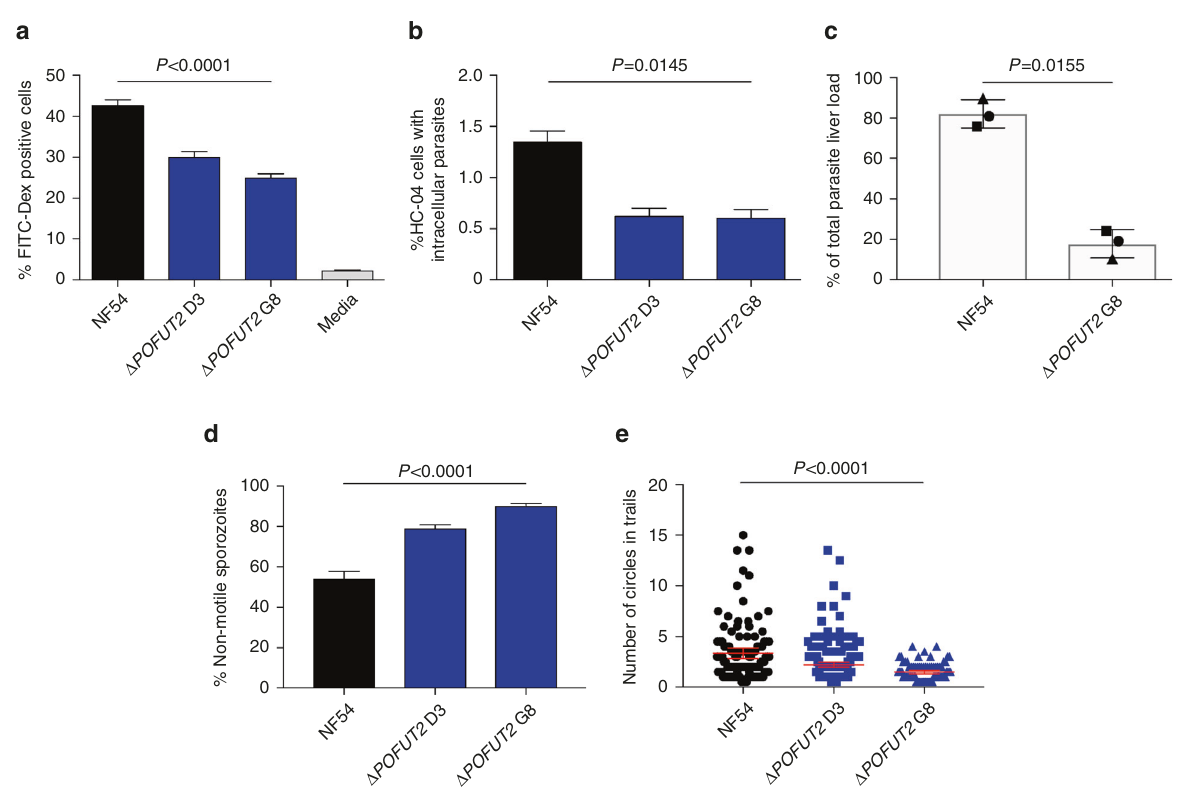
Fig. 3 POFUT2 facilitates P. falciparum liver infection. a Percentage of traversed (FITC-dextran positive) human HC-04 hepatocytes by salivary gland sporozoites. b Percentage of HC-04 cells with intracellular parasites 24 h after addition of sporozoites to cells. Data is the mean ± S.E.M. from three ( a ) and two ( b ) independent experiments. c Parasite liver load measured by qPCR showing the fi tness of Δ POFUT2 versus parental NF54 sporozoites following coinfection of three humanized chimeric liver mice. Each symbol corresponds to the same coinfected mouse. Data are mean ± S.E.M. d Percent of sporozoites that are non-motile in a two-dimensional gliding motility assay. e Number of circles per trail produced by gliding sporozoites (non-motile parasites removed). Data in d , e is mean ± S.E.M. or 95% con fi dence interval, respectively, from two independent experiments. P -values are for both mutant clones compared to NF54, calculated using the Kruskal – Wallis one-way ANOVA, except panel c , which compared one mutant clone to NF54 in each of three mice using the paired t endogenous promoter (Supplementary Fig. 7A). Integration of the HA epitope cassette was validated by Southern blot (Supplementary Fig. 7B) and POFUT2-HA expression con fi rmed by immunoblot using anti-HA antibodies. POFUT2-HA migrated as a single species of circa 60 kDa in asexual parasites, consistent with a predicted mass of 59 kDa (Supplementary Fig. 7C).